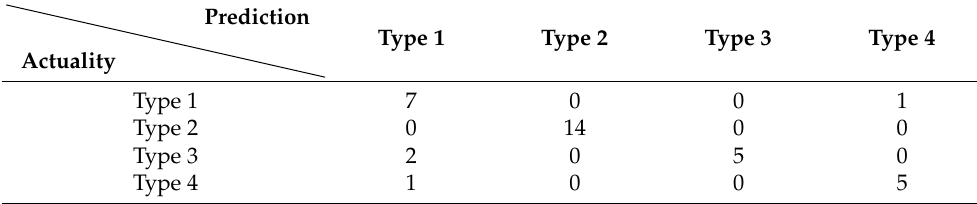
Table 5. Confusion matrix of the LR